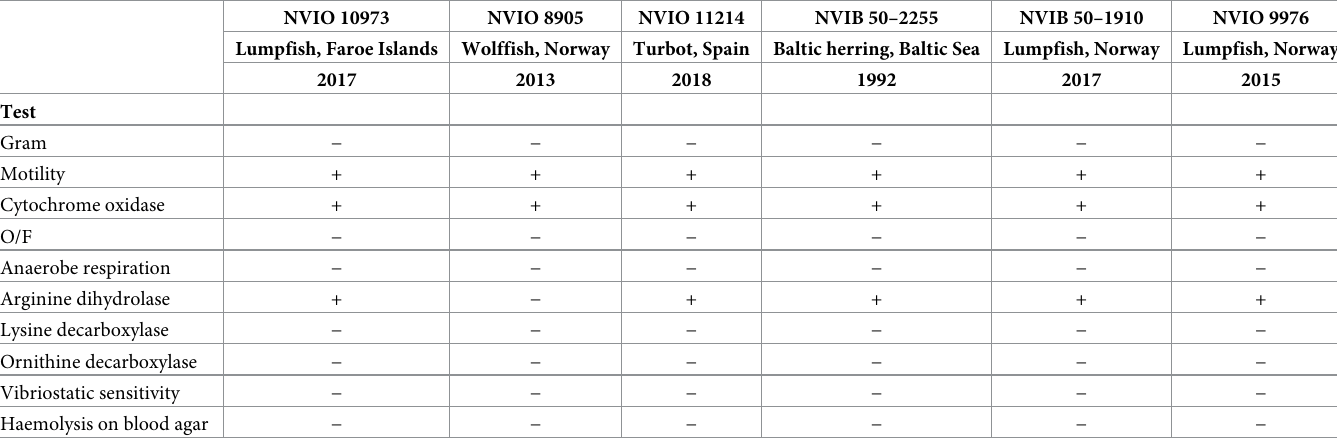
Table 4. Phenotypic characteristics of six P . anguilliseptica isolates (isolate number, geographic origin and time of